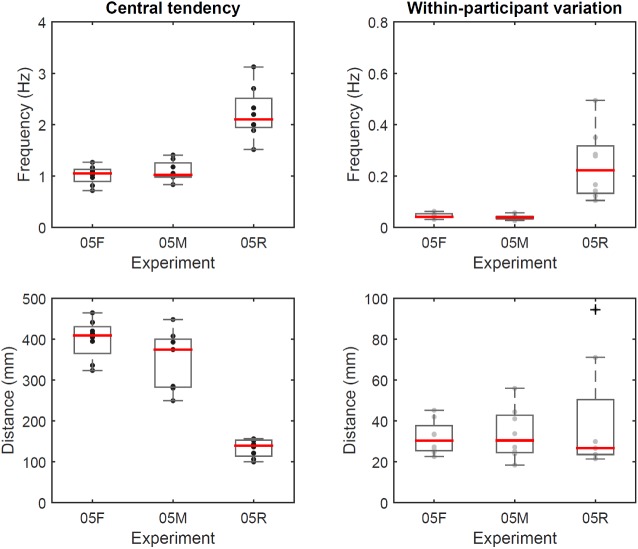
Results for experiment #5.Boxplots of sawing frequency (top) and excursion amplitude (bottom), showing participant-specific median values (left) and within-participant variation (right) in experiment #5. Black/grey dots: individual data points. 05F –free arm movements, 05M –mimed sawing, 05R –real sawing.